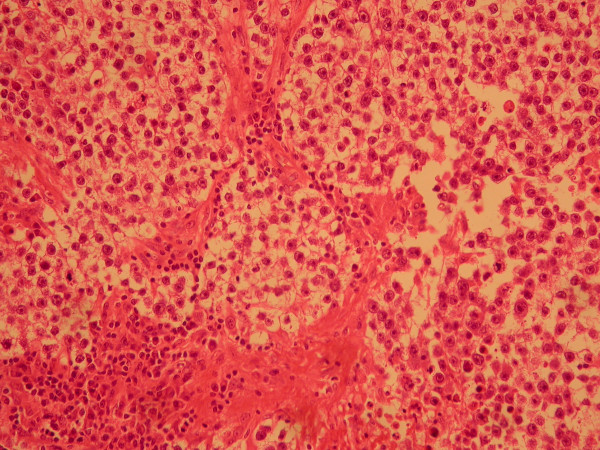
Histological appearnce of the left testis demonstrating testicular seminoma.